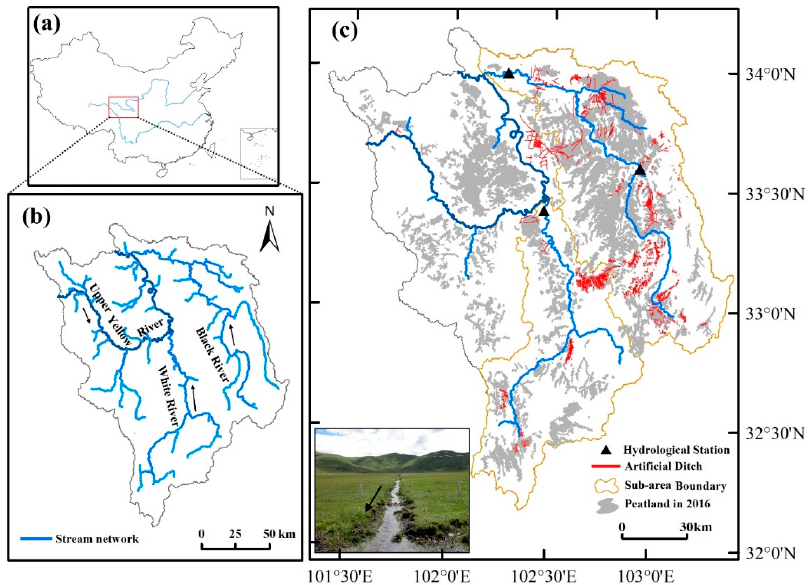
Figure 1. Location of the Zoige Basin and geographic characteristics of the artificial ditches. ( a ) Geographic position of the Zoige Basin in China. ( b ) The Upper Yellow River and its two main tributaries within the Zoige Basin, White and Black Rivers. ( c ) Spatial distribution of Zoige peatlands and artificial ditches that are mainly concentrated in White and Black River watersheds. Dashui at the lower section, Zoige at Zoige County, and Baihe at Tangke Town are three hydrological stations recording water discharges from their contributing areas.